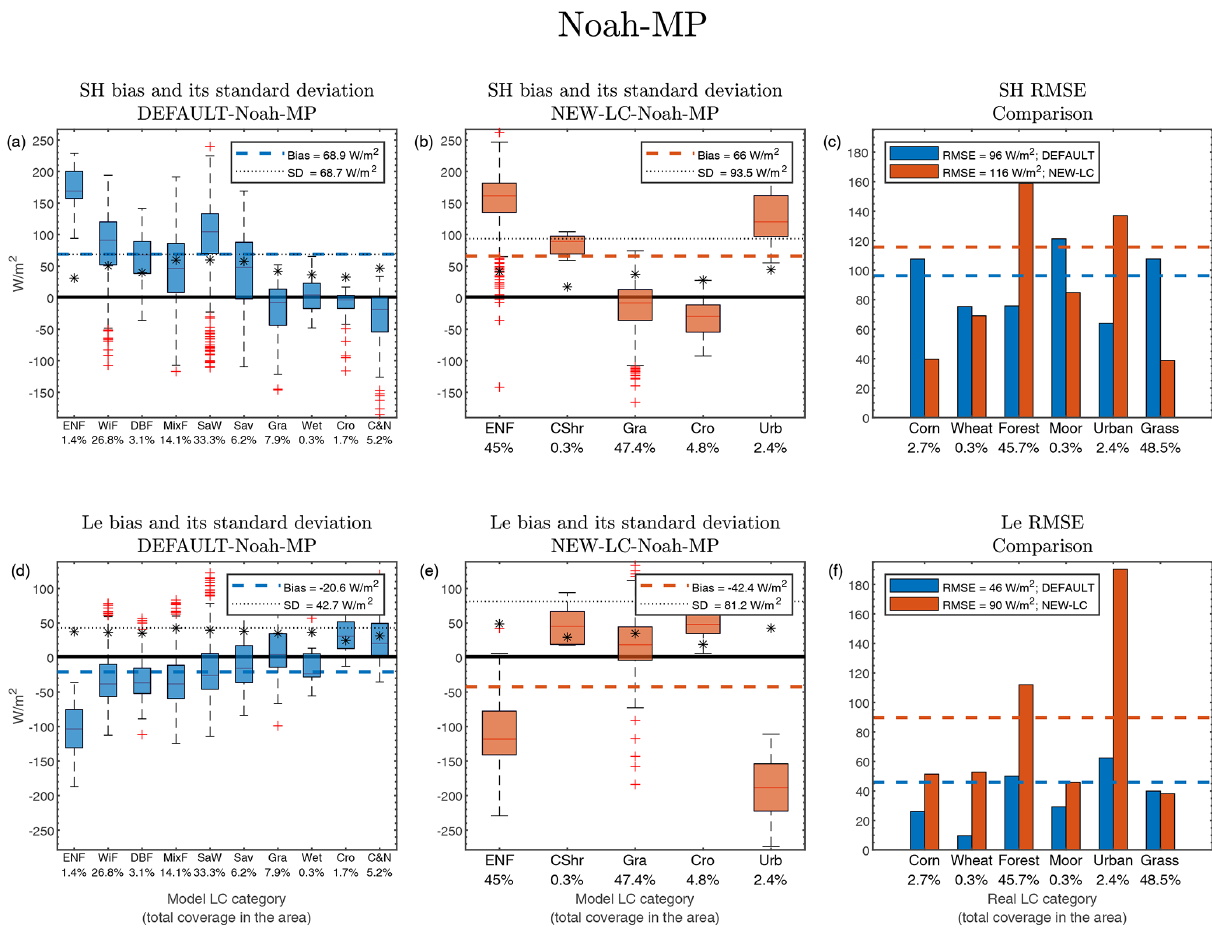
Figure 4. Same as in Fig. 3 but for